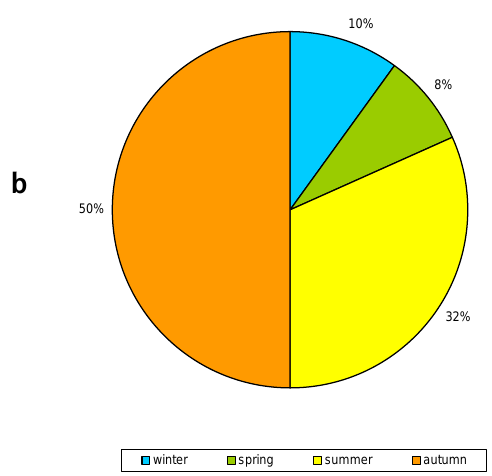
Fig. 4. Seasonal distribution of flood events recorded in Figure 4. Seasonal distribution of flood events recorded in Catalonia (1982-2007)